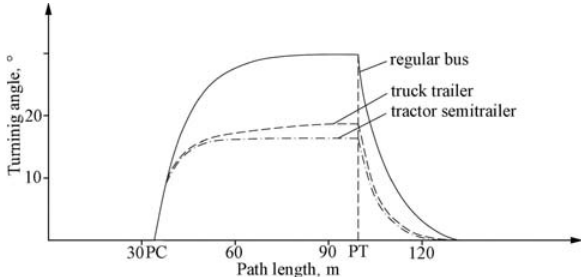
fig. 2. Theoretical angles of vehicle turning for steering path shaped without transition curves ( R = 18 m, turning angle